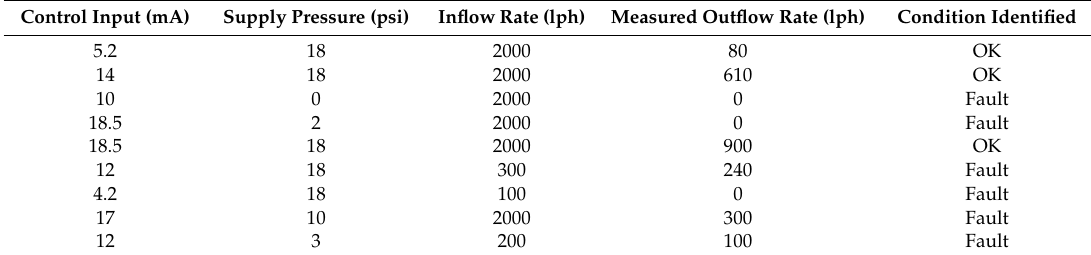
Table 1. Test results of fault-detection